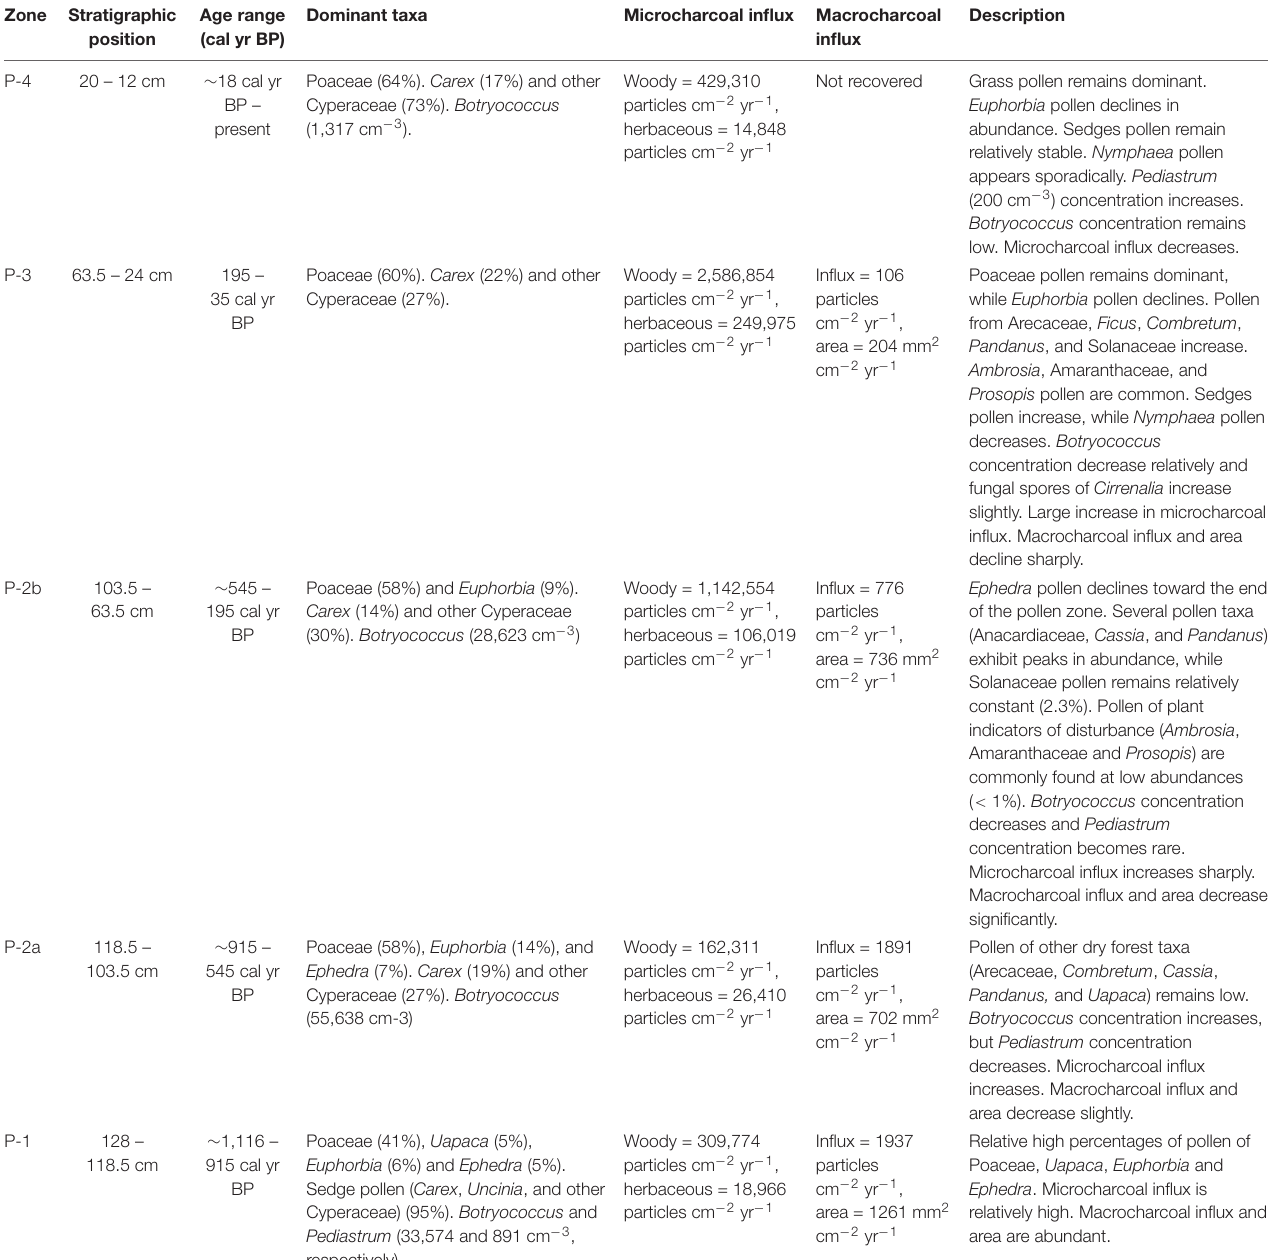
TABLE 2 | Zones of Namonte pollen record. Zonation was based on the CONISS